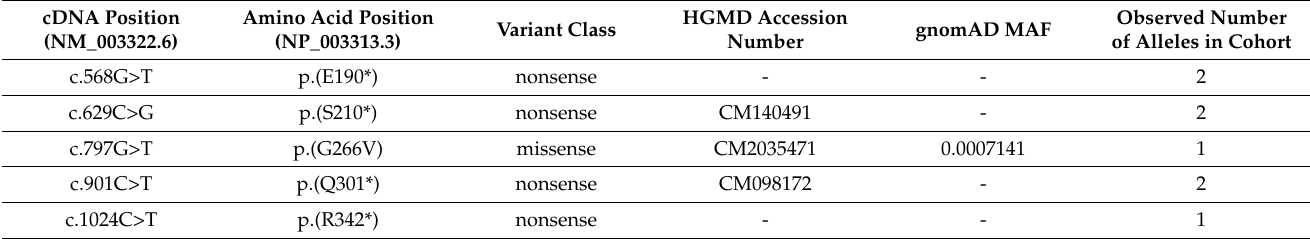
Table 2. Observed TULP1 variants in this